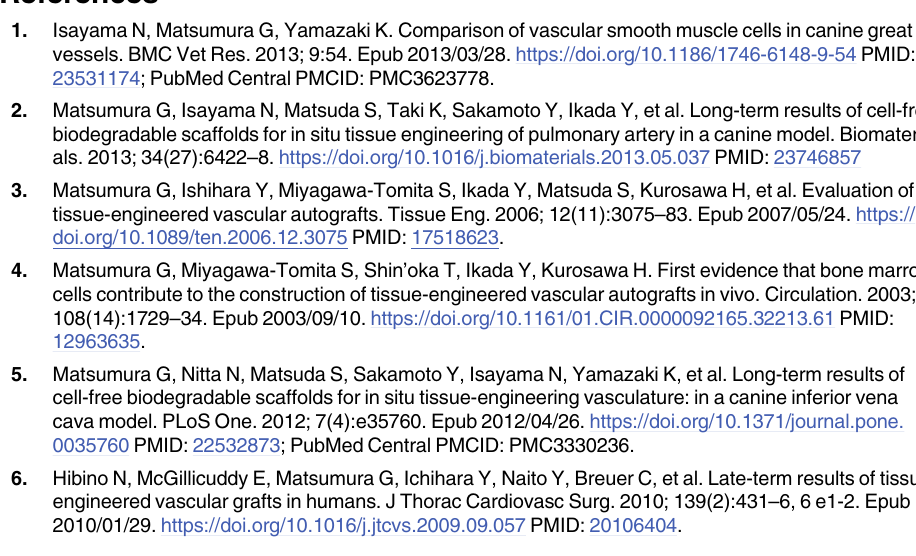
S1 Table. Raw data of minimal diameter of iTEV. Raw data of time-course changes in mini- mal diameter of iTEV by dample are